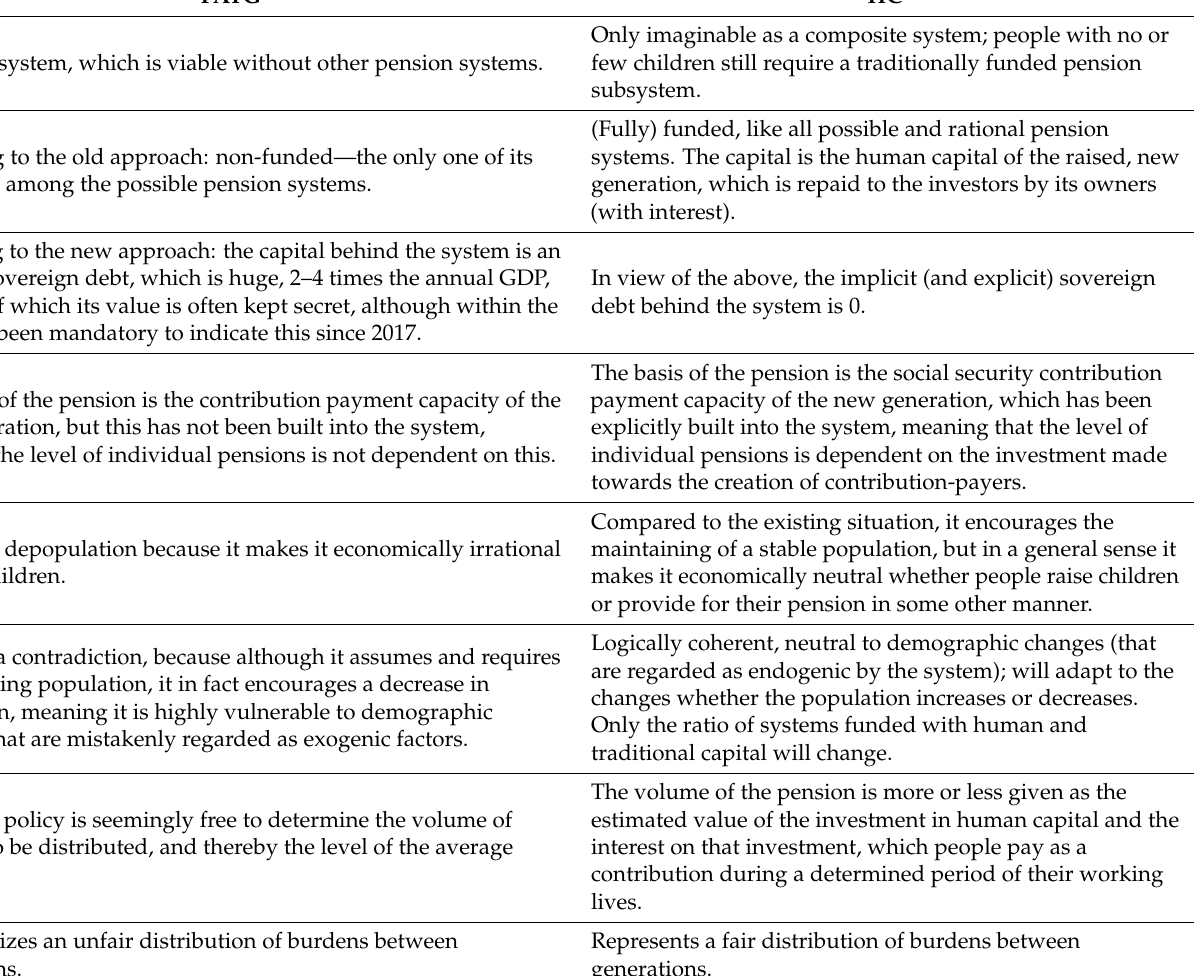
Table 1. The main characteristics of the pay-as-you-go (PAYG) and human capital (HC) systems. PAYG A “pure” system, which is viable without other pension